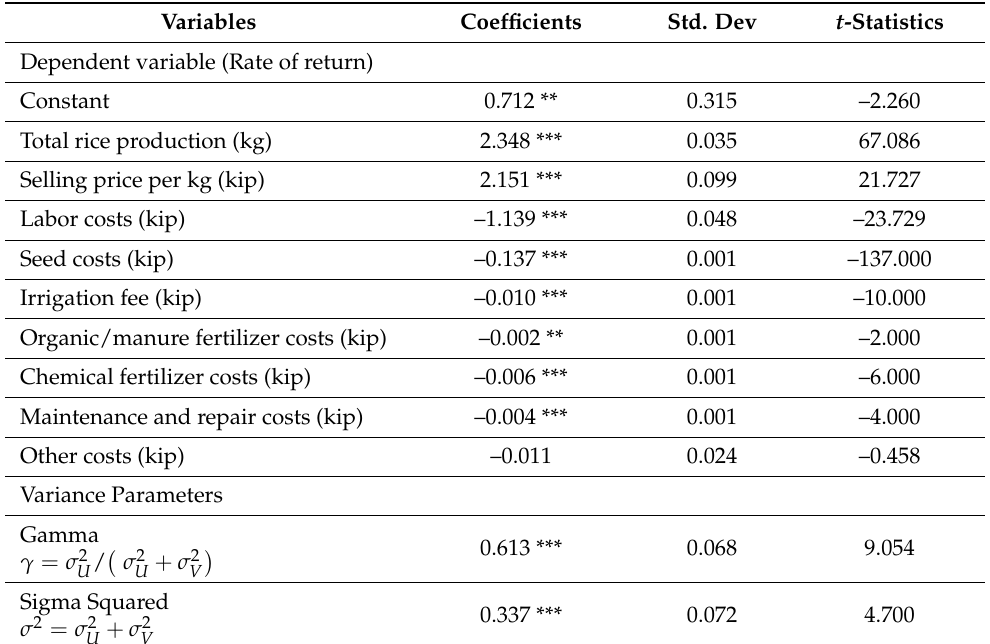
Table 2. Estimates from Stochastic Profit Frontier Model of Wet-Season Lowland Rice. Variables Coefficients Std. Dev t